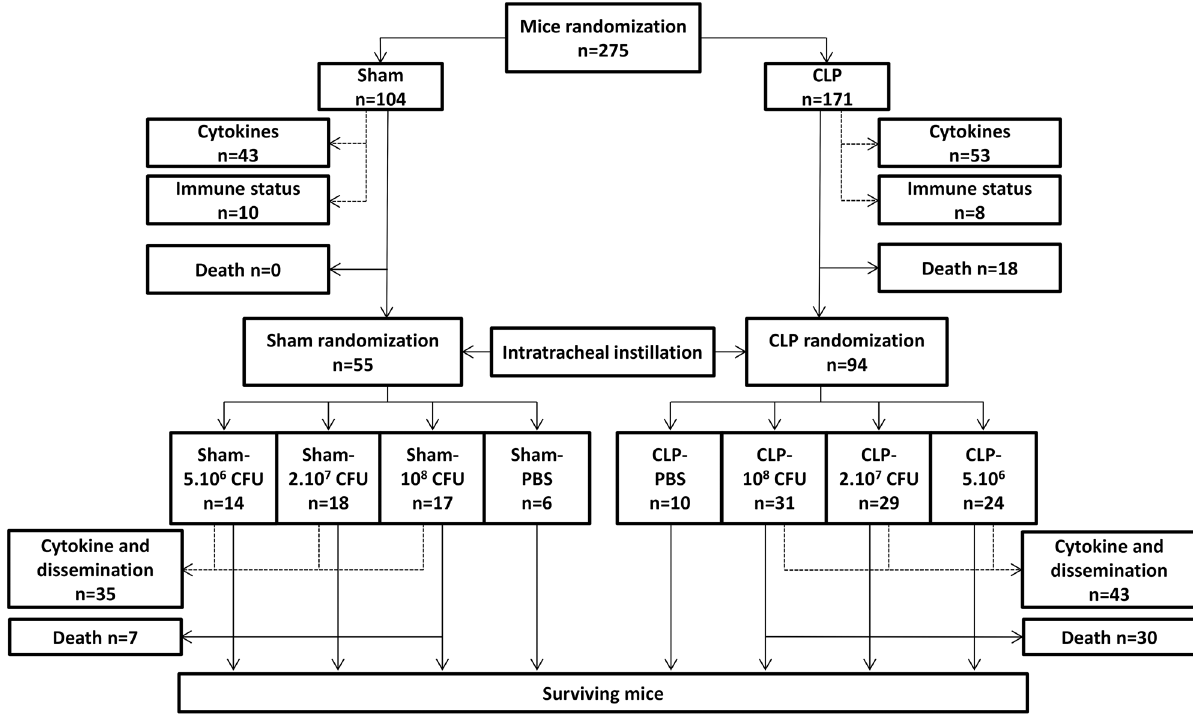
Fig 1. Study design flowchart. Mice were randomized into 2 groups: Sham or CLP. In each group, some mice were used to evaluate cytokines levels and immune status (dotted arrows) and were therefore not included in the survival evaluation after the first septic insult. Note that some mice were used for both cytokine assessment and immune status evaluation. The second stage started right after the intratracheal administration of Pseudomonas aeruginosa . Sham and CLP groups mice were randomized into 4 different groups according to the amount of bacteria they received: Sham- or CLP-PBS were instilled with PBS (vehicle) only; other groups were instilled with the different bacterial loads as follow: Sham- or CLP-5.10 6 CFU, Sham- or CLP-2.10 7 CFU and Sham- or CLP-10 8 CFU. Systemic cytokine release and spleen and liver bacteria dissemination were evaluated in the same mice. These mice were not included in the survival evaluation of the second hit. “ n ” represent the animal number in each condition.